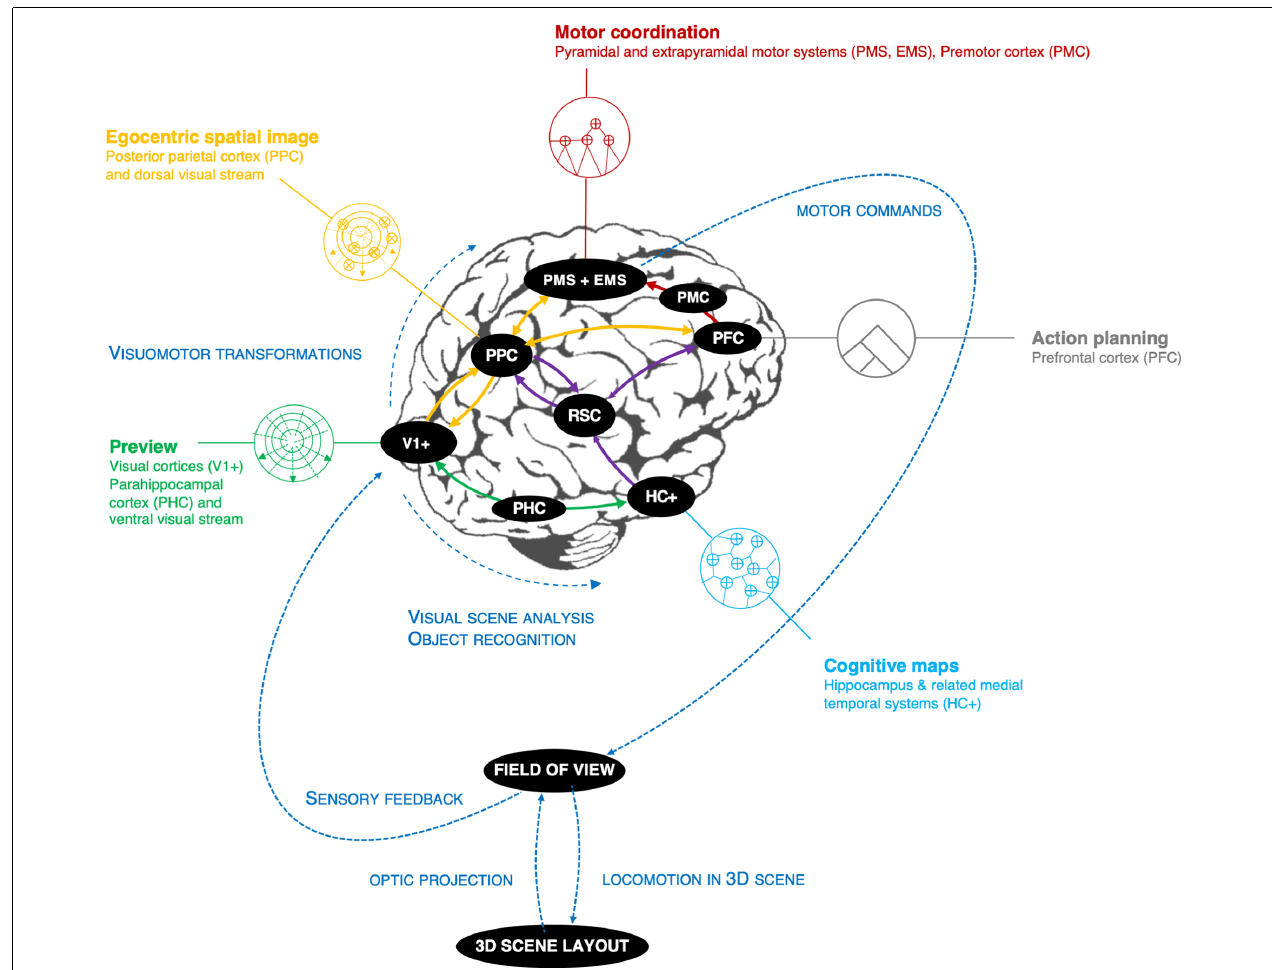
FIGURE 7 | Wayfinding circuits, an approximate neural hierarchy that aligns with the information-processing hierarchy in Figure 6 . PFC, prefrontal cortex; PMS + EMS, pyramidal and extrapyramidal motor systems (incl. related sensory systems); PPC, posterior parietal cortex; V1+ visual areas (here incl. parahippocampal and parietal place areas) S1+, somatosensory system; PHC, parahippocampal cortex; HC+, hippocampus and related medial temporal structures; RSC, retrosplenial